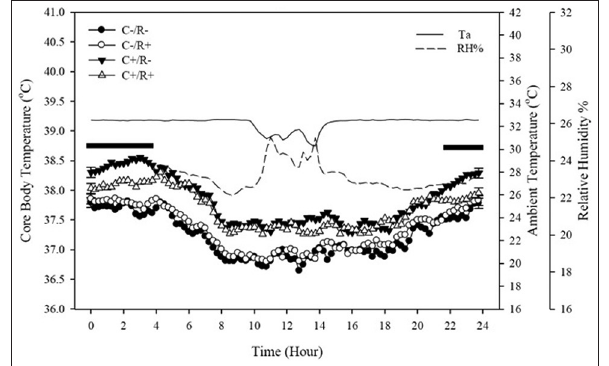
Figure-4: Daily mean (±SE) core body temperature of rats while maintained under chronic heat stress (HS) challenge (T =32.28±1.00°C) between days a 29 and 34. Thermoneutrality (ambient temperature; T =23.15±0.04°C) was maintained between days 0 and a 28. Then, HS was imposed in two subsequent phases; an acute HS wave (T =35.86±0.37°C; 00:00-09:00 h) on a day 29 of the trial, followed immediately by chronic HS. The treatments were hypercholesterolemia-inducing (HC) diet (C+) and/or resveratrol (R+): C-/R- (control) group fed a control diet throughout the trial. The C+/R- group consumed the HC diet (containing 1% purified cholesterol along with 0.5% cholic acid, with high-fat-based mixture), throughout the trial. The C-/R+ was fed the control diet and received a dose of 13 mg/kg BW/day of purified trans- resveratrol by oral gavage during the past 5 days of the trial. The C+/R+ group consumed the HC diet and received the R+ treatment as explained. Horizontal bars signify cholesterol by resveratrol by time interactions